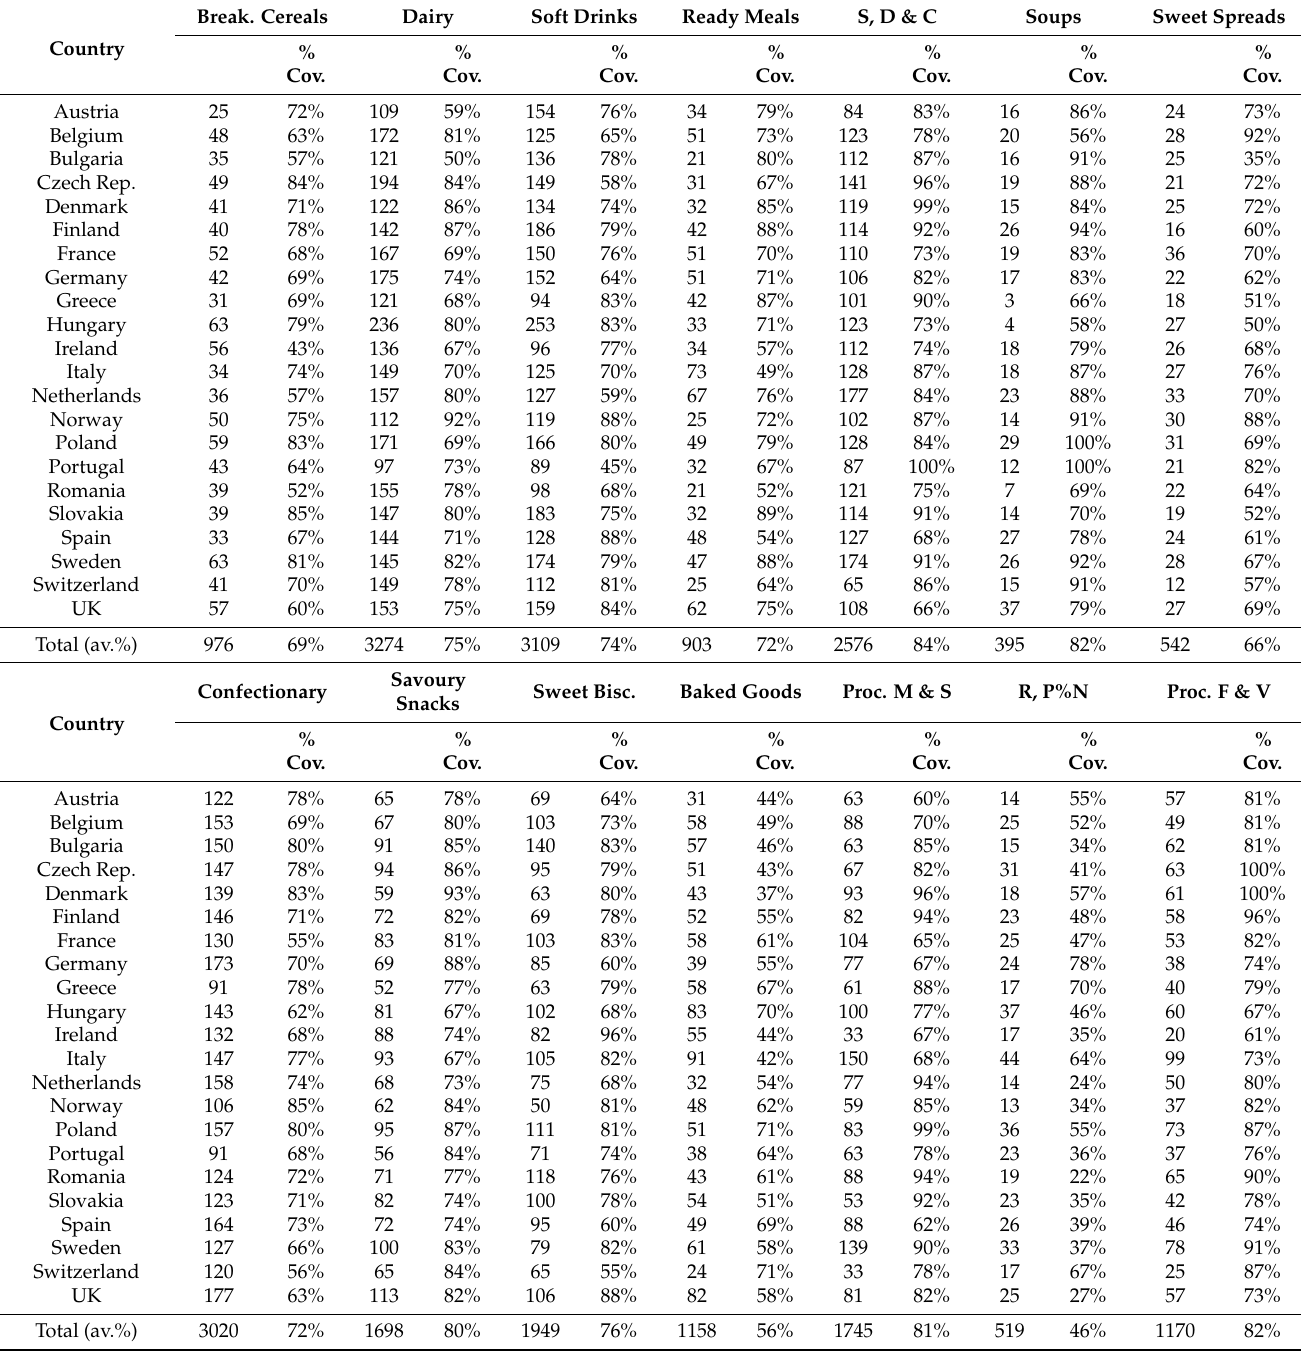
Table 1. Number of products extracted from the Euromonitor database and their respective market coverage (in %) in 2018, per category and